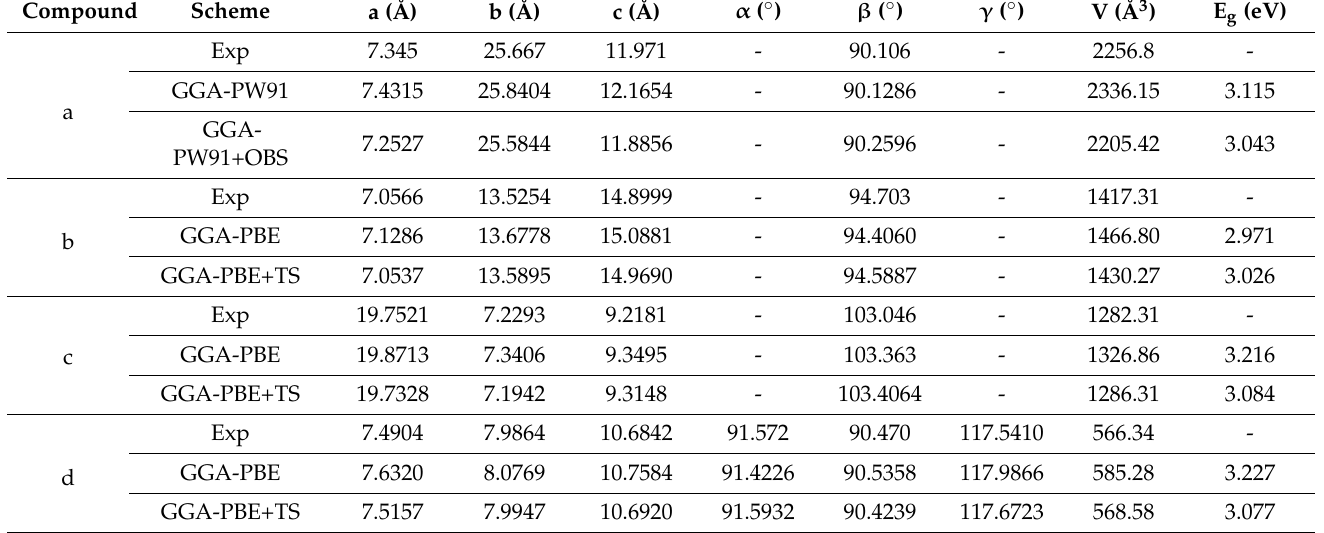
Table 6. Experimental and optimized unit cell parameters and calculated optical gap energies with different studied structures using DFT and DFT+D